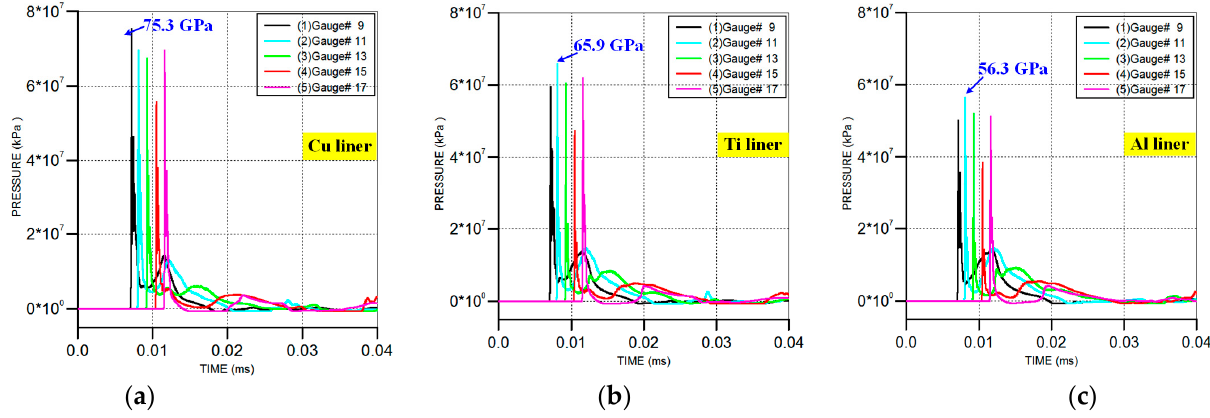
Figure 12. Pressure–time history curves of gauge points during the composite jet formation process: ( a ) reactive material–Cu jet; ( b ) reactive material–Ti jet; ( c ) reactive material–Al jet.